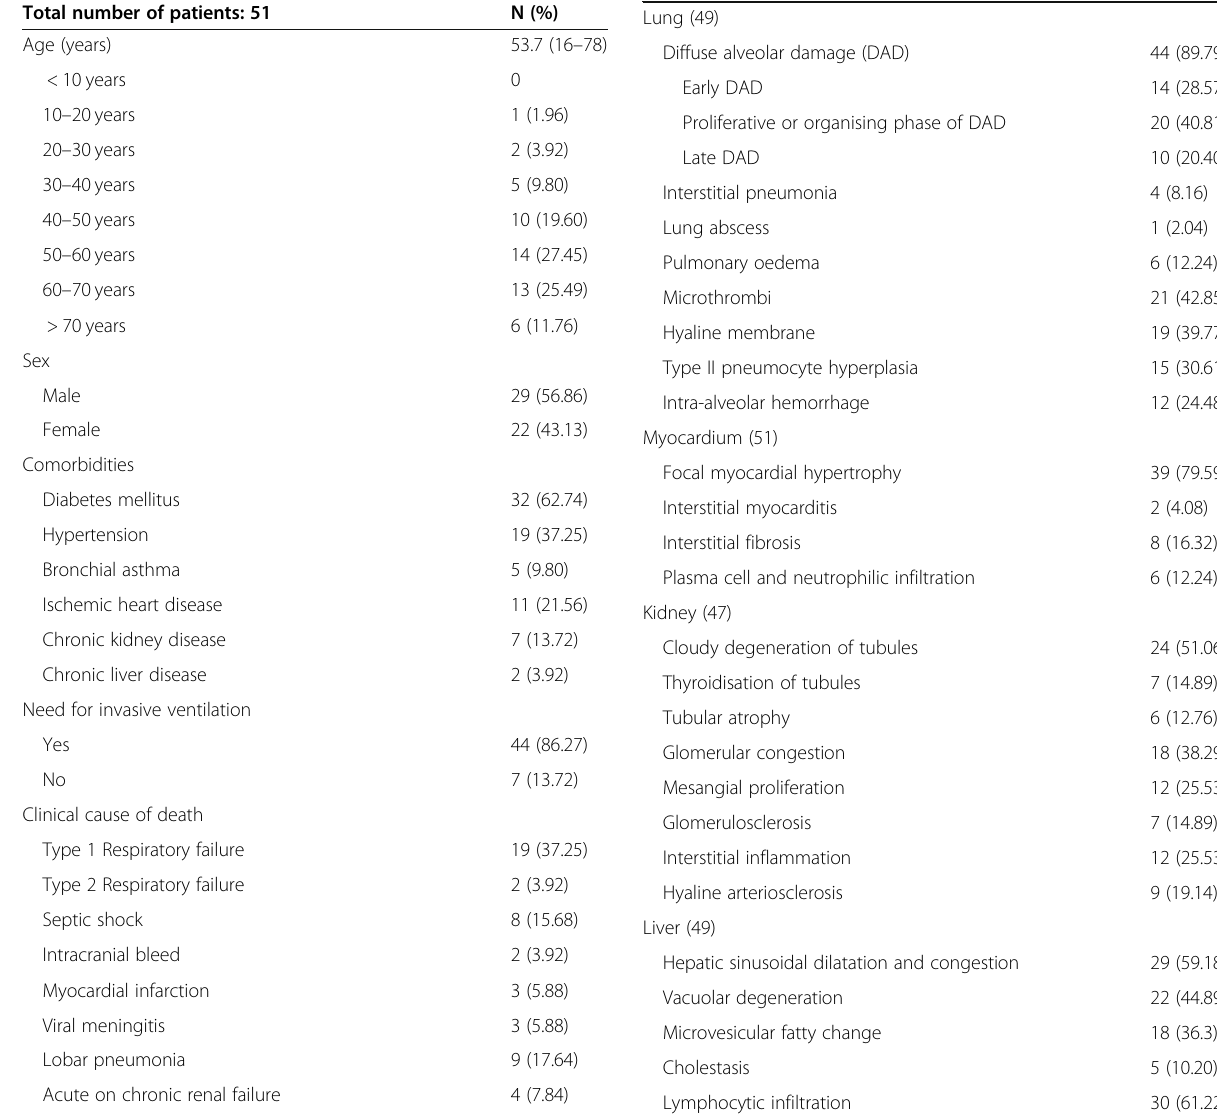
Table 2 Findings in microscopic analysis of MIA tissue samples Histopathological